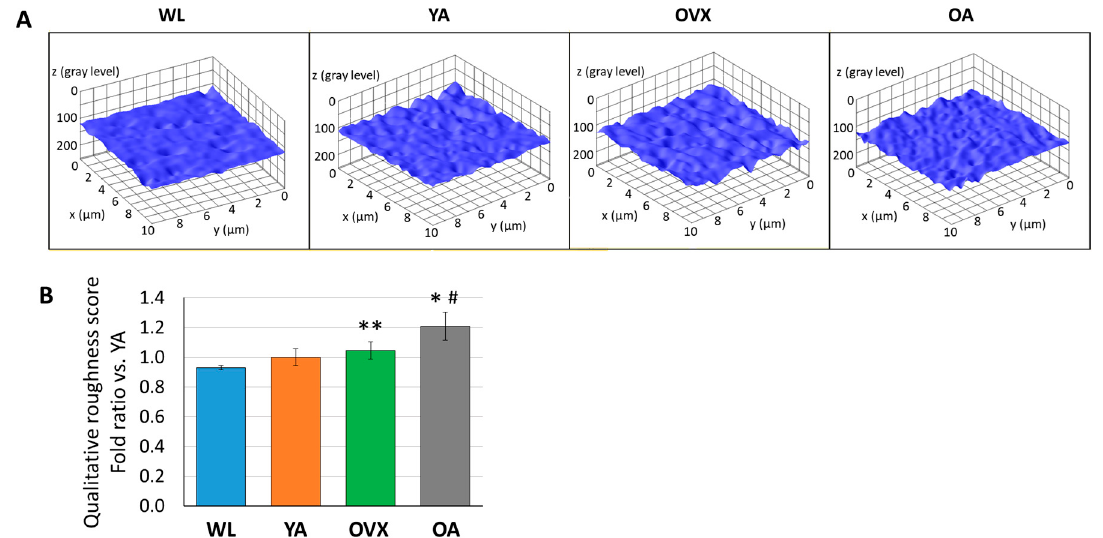
Figure 4. ( A ) Representative 3D plot images of surface roughness by ImageJ from SEM images of each model. ( B ) Histograms of qualitative roughness score from three different individuals in each group. Values are normalized by that of a young adult and indicate the means ± standard error (S.E.). Significant differences between the WL group are indicated by *, p < 0.05 and **, p < 0.01, and those between the YA group are indicated by # , p < 0.05.